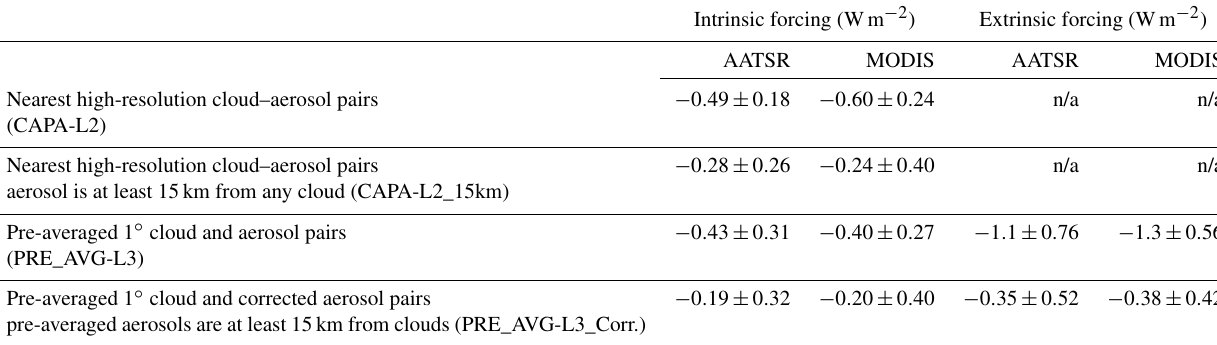
Table 2. Aerosol–cloud radiative forcing estimated using Eq. (4) based on ORAC applied to AATSR over the 2002–2012 period and ORAC applied to MODIS collection 6 over JJA 2008 for low-level warm maritime clouds observed between 60 ◦ S and 60 ◦ N. Retrievals are not used if they are identified over land or ocean regions with sea ice. Uncertainties are calculated on the basis of the propagated standard error of the regression slope through the radiative forcing